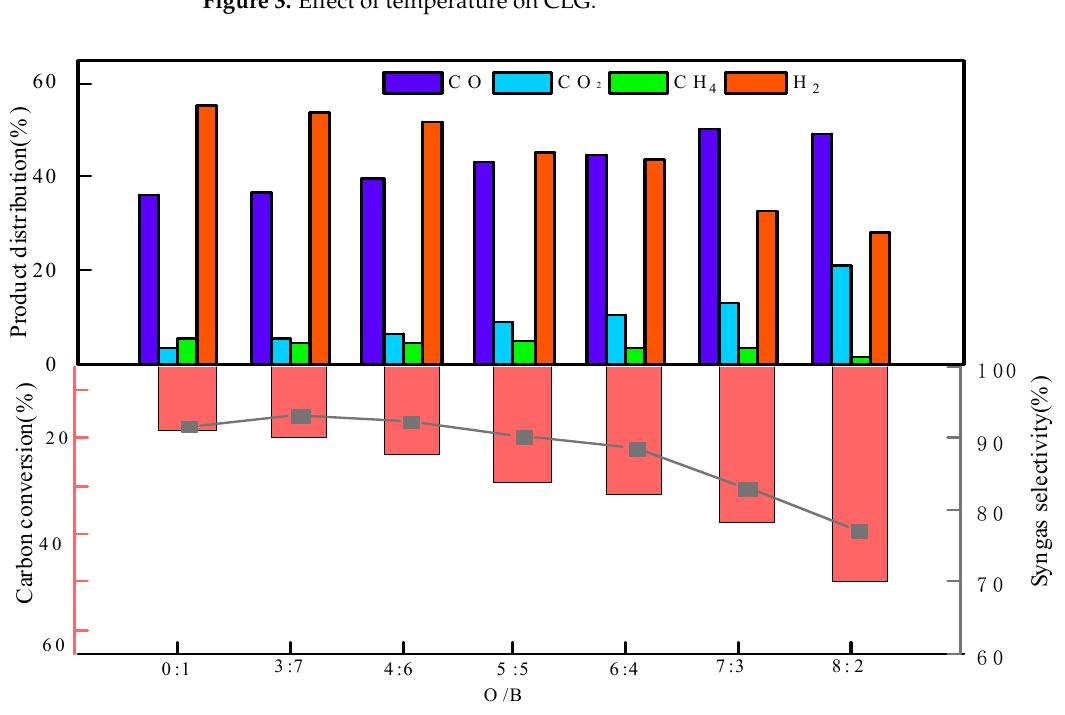
Figure 3. Effect of temperature on CLG.